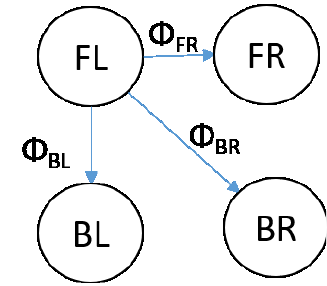
Figure 2. Central Pattern Generator (CPG) structure. The legs are labelled as BL: back left, BR: back right, FL: front left, and FR: front right. The synchronization phase between neurons is related to the adopted locomotion